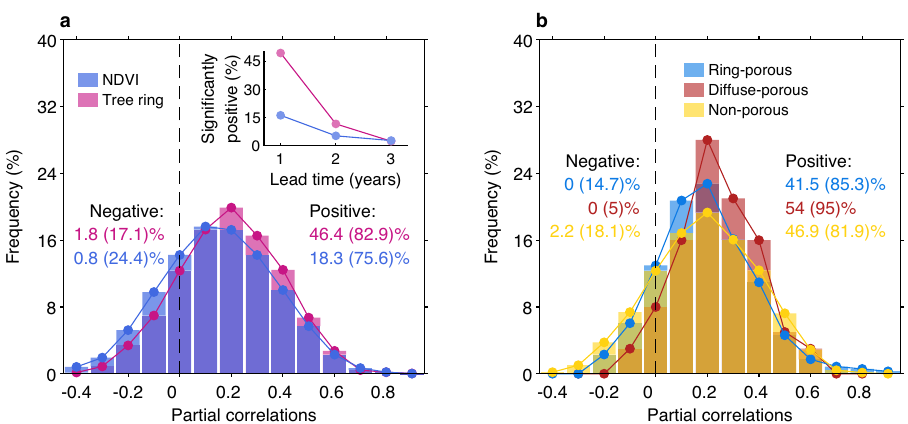
Fig. 4 Observed interannual vegetation growth carryover. a The histogram shows the frequency distribution of the partial correlations between Normalized Difference Vegetation Index (NDVI), or tree-ring width, of each year and that of the preceding year, after controlling for the climatic variable of both years. b Frequency distribution of the partial correlations between tree ring width of each year and that of the preceding year, for ring-porous, diffuse- porous, and non-porous trees (classi fi cation details in Supplementary Table 1). Numbers show the percentage of grids (or tree samples) showing statistically signi fi cant ( p < 0.05) negative/positive partial correlations, with the bracketed numbers showing the percentage of all negative/positive correlations. The inset plot of a shows the percentage of grids (or tree samples) showing signi fi cantly ( p < 0.05) positive correlation between present and preceding years ’ NDVI (or tree ring width) with lead times ranging from 1 to 3 years. Note that all variables are detrended before performing partial correlation